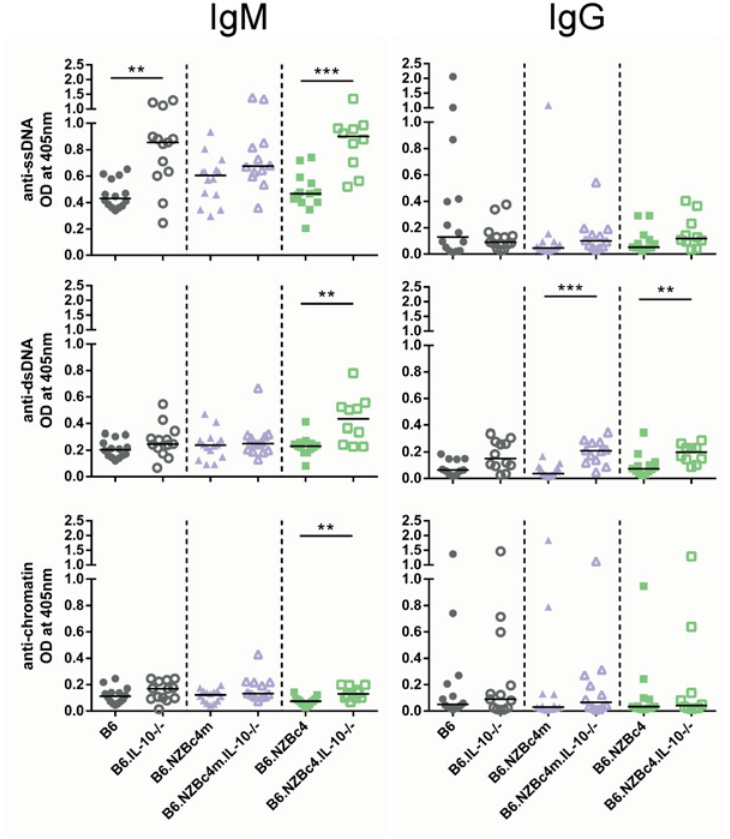
Fig 3. Knockout of IL-10 in B6.NZBc4 but not B6.NZBc4m mice results in a breach of tolerance to ssDNA, dsDNA, and chromatin. Levels of anti-ssDNA, -dsDNA, and – chromatin antibodies were measured in 4 month old mice by ELISA. Each point represents a single mouse, with the lines for each group representing the median. Statistical analyses were carried out using a Mann-Whitney U test between homozygous and IL-10 knockout animals of the same genetic background. * P < 0.05, ** P <